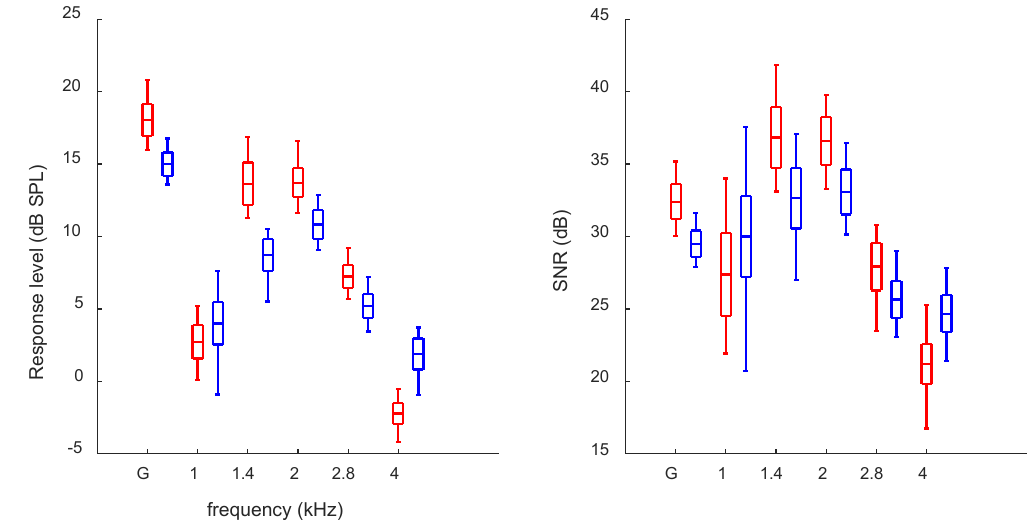
Figure 1. Average response levels (left panel) and SNRs (right panel) for TEOAEs without CAS measured over one year for left and right ears (blue and red, respectively). Boxes depict the mean and standard deviations, and the whiskers show the minimum and maximum. G, global (broad-band).